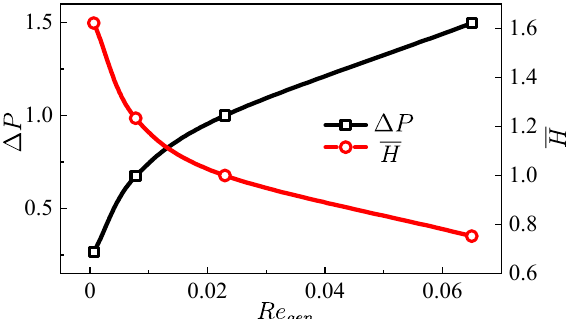
Figure 12. The dimensionless pressure drop ( ∆ P ) and the mean cross-sectional apparent viscosity ( H ) for various Re gen . The pressure drop and the mean outlet apparent viscosity when θ w = 1 and Re gen = 2.3 × 10 − 2 are used as reference parameters.